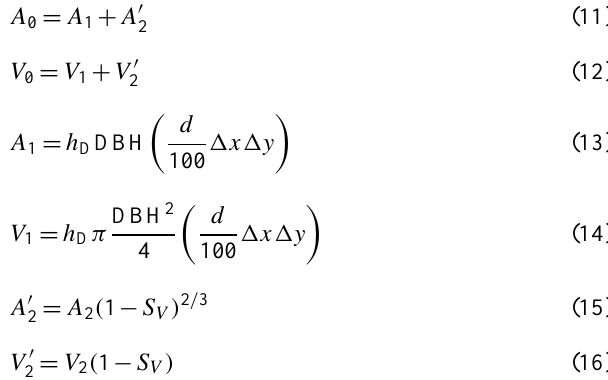
Fig. 3. Typical ground topography of the study area